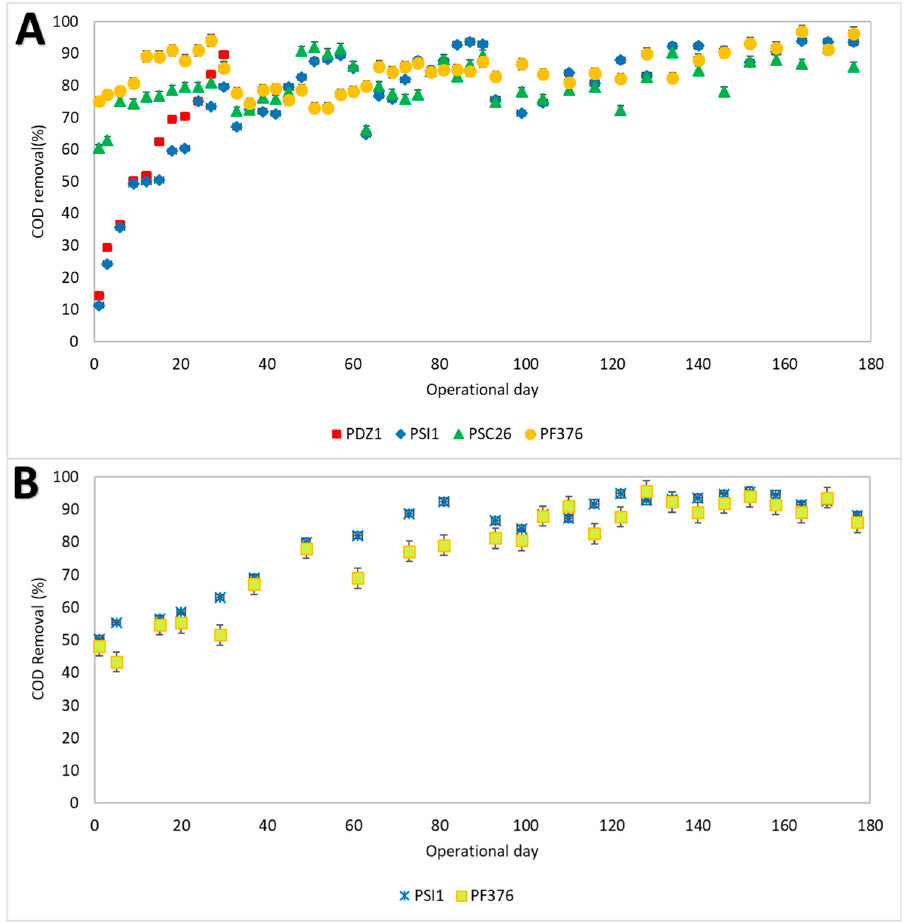
Figure 7. The COD by granular biomass for Pseudomonas fluorescens PSC26 (PSC26), Pseudomonas fluorescens 376 (PF376 ), Pseudomonas stutzeri I1 (PSI1), and Pseudomonas denitrificans Z1 (PDZ1) fed fluorescens 376 (PF376), Pseudomonas stutzeri I1 (PSI1), and Pseudomonas denitrificans Z1 (PDZ1) fed with sodium acetate ( A ) and methanol ( B ). with sodium acetate ( A ) and methanol ( B